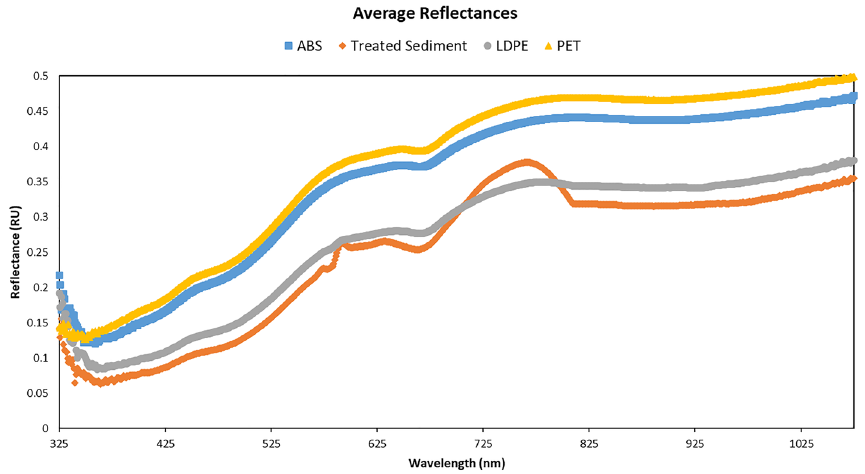
Figure 2. The average reflectance (RU) of ABS (square), treated beach sediment (diamond), LDPE (circle), and PET (triangle) against wavelength (in nm) across all concentrations in treated beach sediment. The average reflectance (RU) of the treated beach sediment without any microplastic is also shown in the